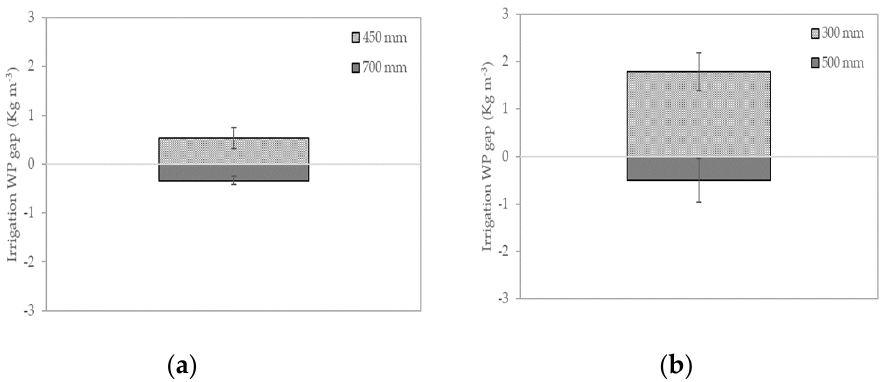
Figure 9. Average simulated irrigation water productivity (WP) gap of the different irrigation water allocation scenarios with respect to the normal irrigation water allocation (reference scenario) for the 30 simulated seasons in the two main productive areas: ( a ) North (Valladolid), and ( b ) South (Sevilla). Vertical bars represent the standard deviation.